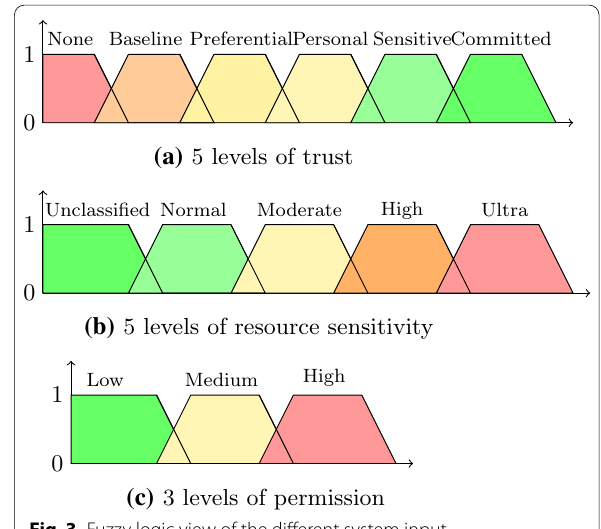
Fig. 3 Fuzzy logic view of the different system